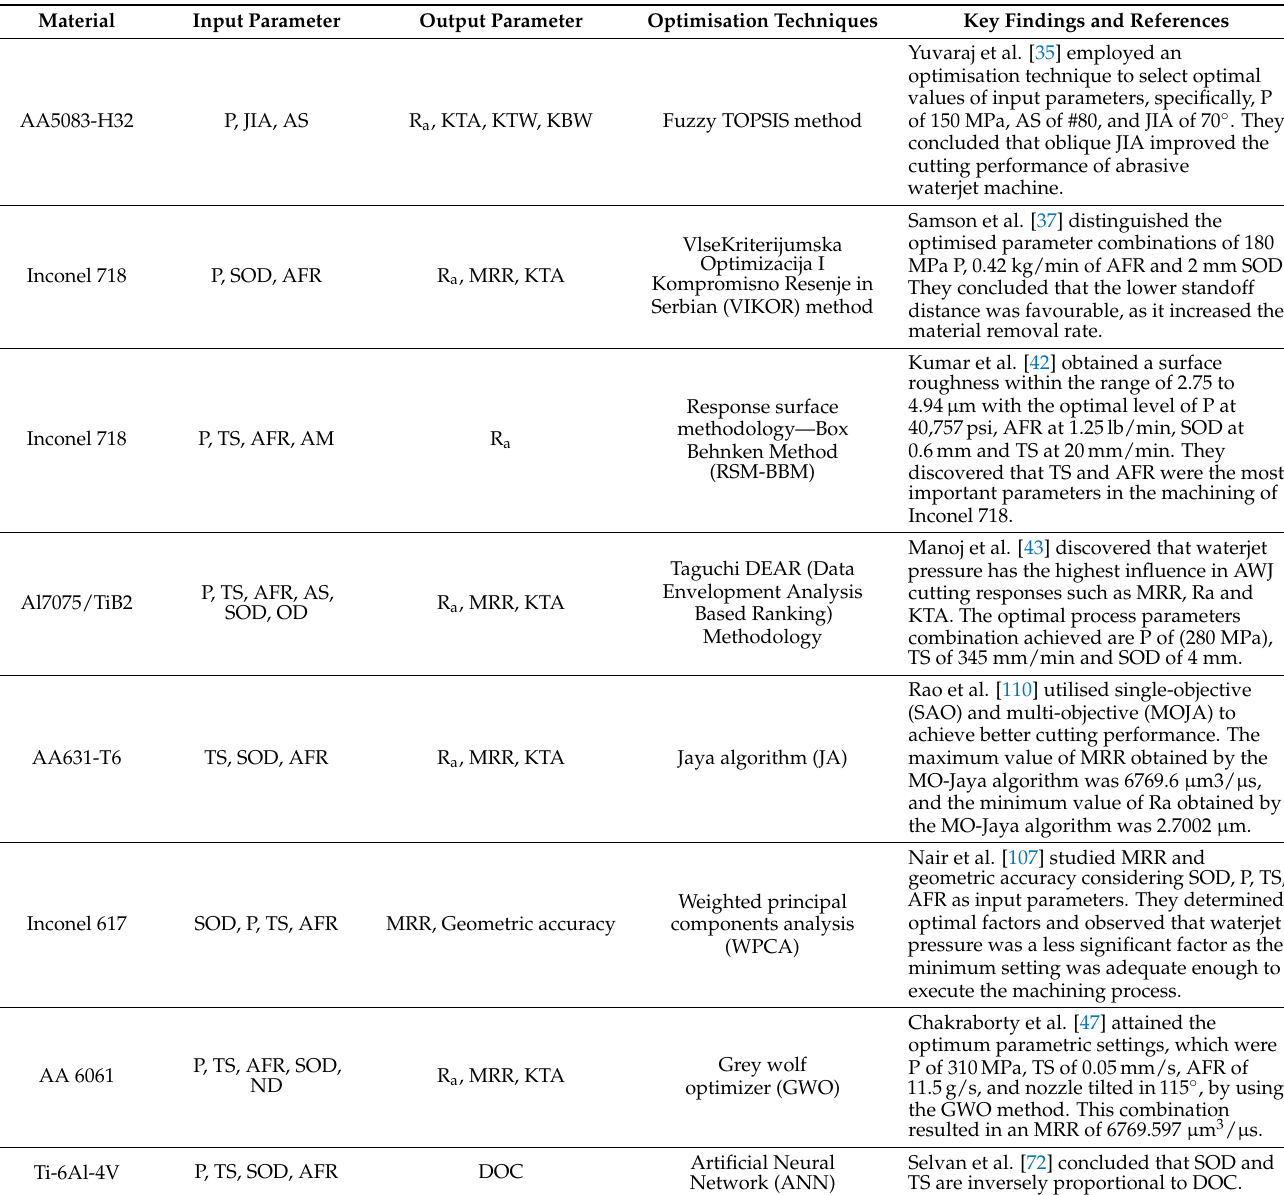
Table 10. A list of several studies (2017 to 2020) with a diverse optimization technique in AWJ cutting